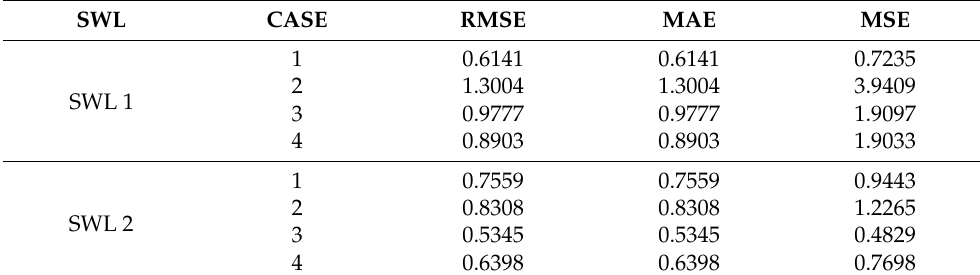
Table 3. Results of the RMSE, MAE, and MSE (ReLU activation